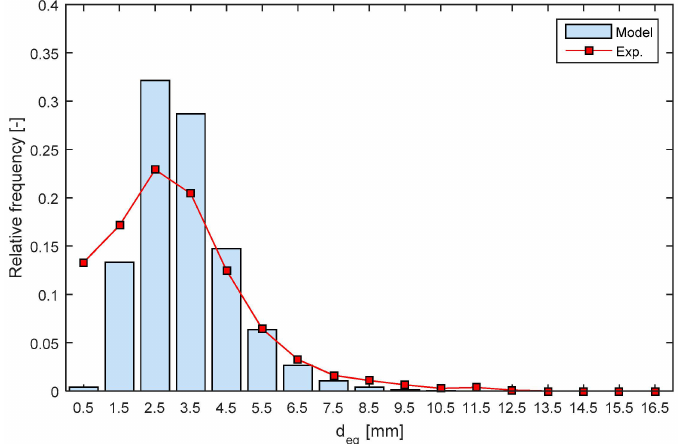
Figure 13. Comparison between PBM results and experimental data: Martinez constant and uniform BSD at the inlet: U G = 0.0037